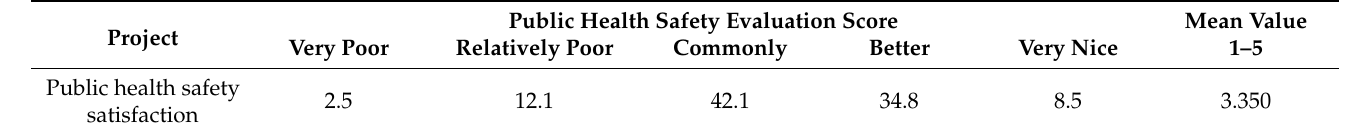
Table 8. Overall satisfaction with public health and safety (unit: %).